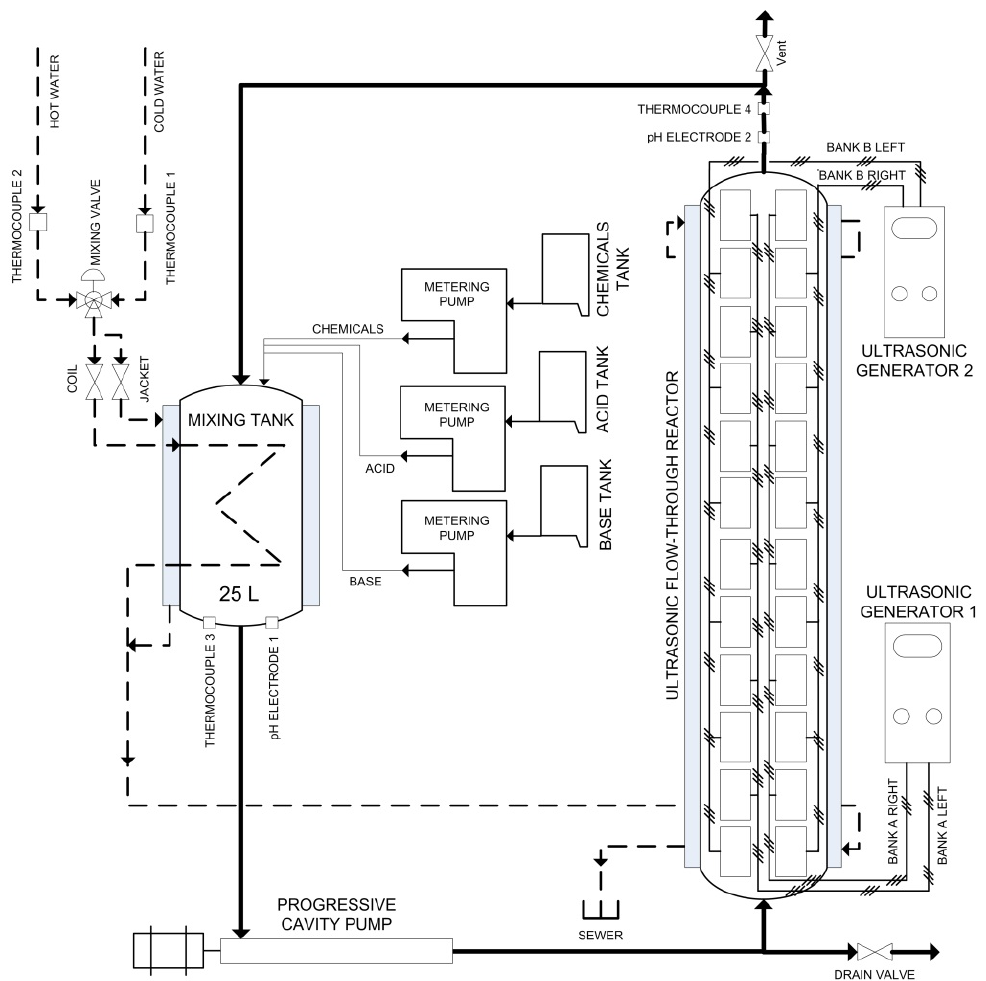
Figure 8. Schematic diagram of the large-scale flow-through